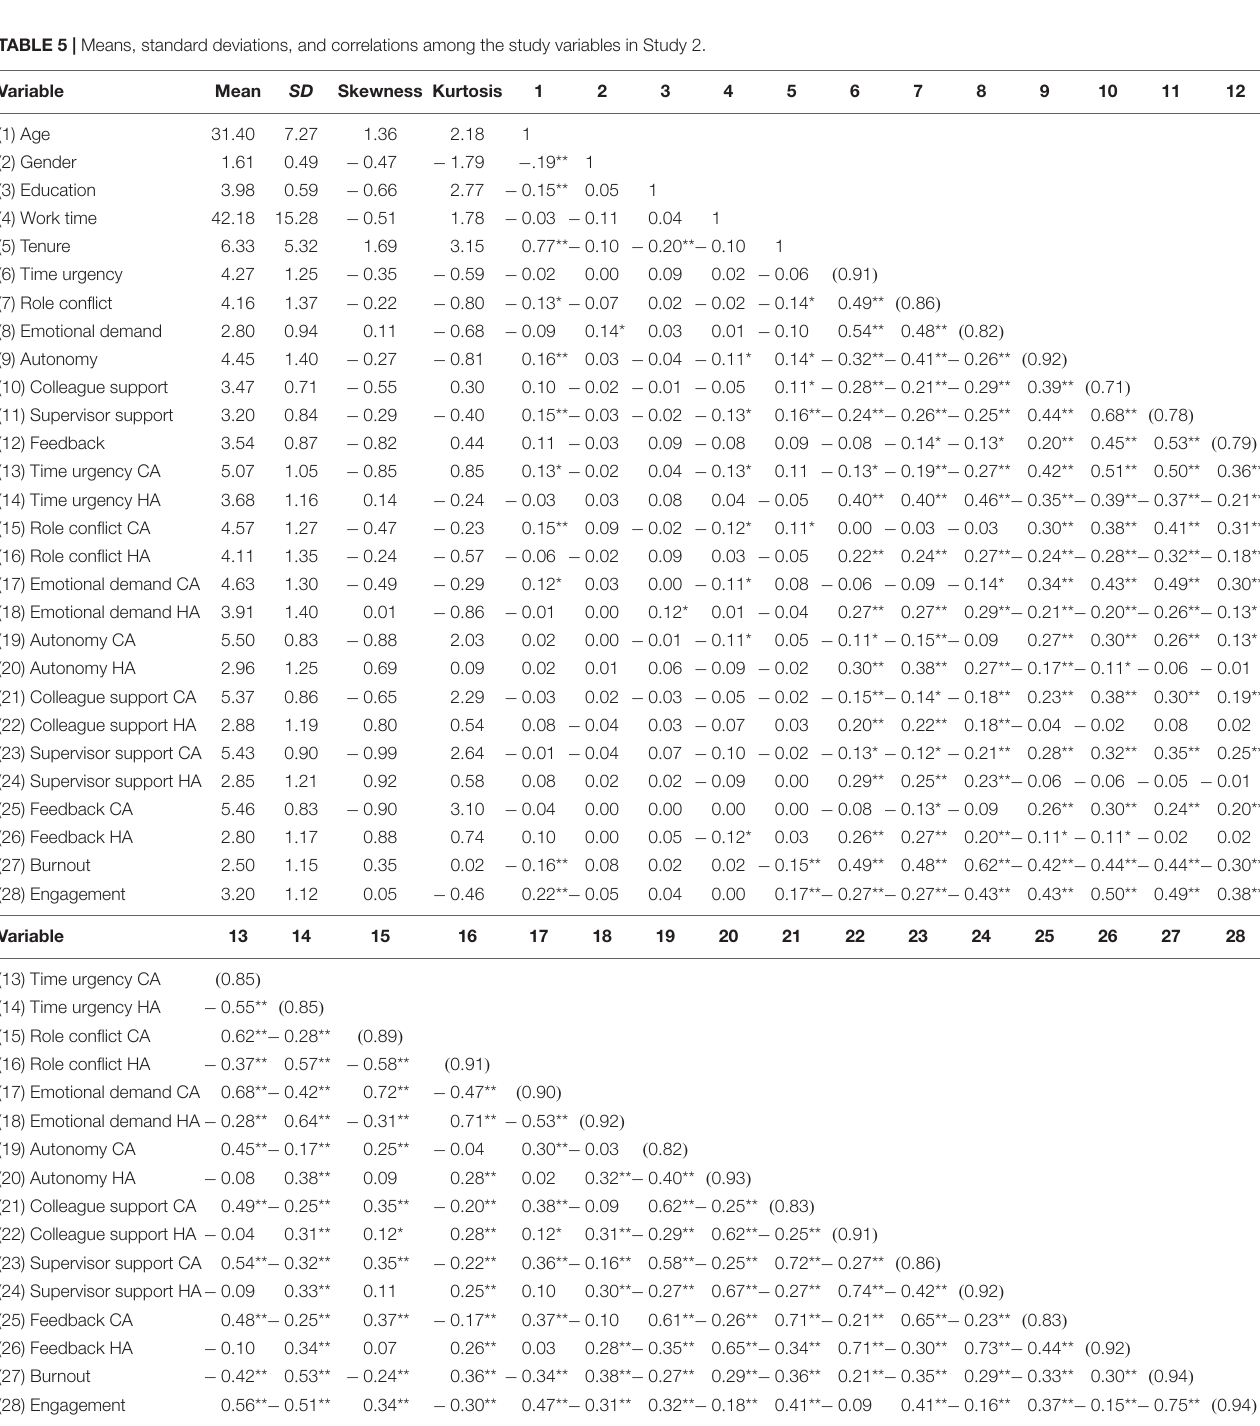
TABLE 5 | Means, standard deviations, and correlations among the study variables in Study 2. Variable